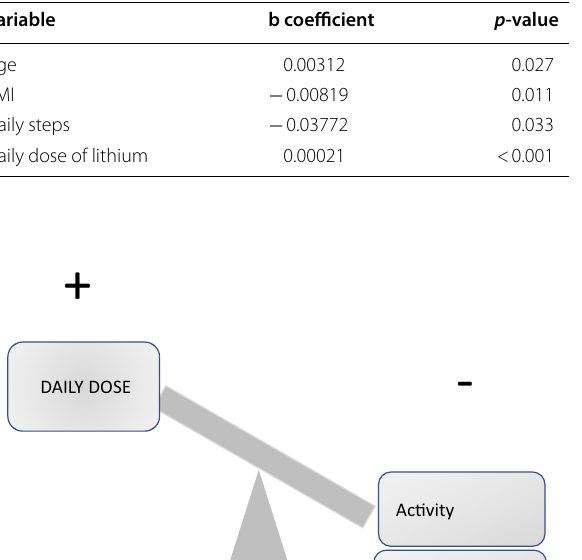
Table 3 Linear mixed‑effects model of lifestyle‑related